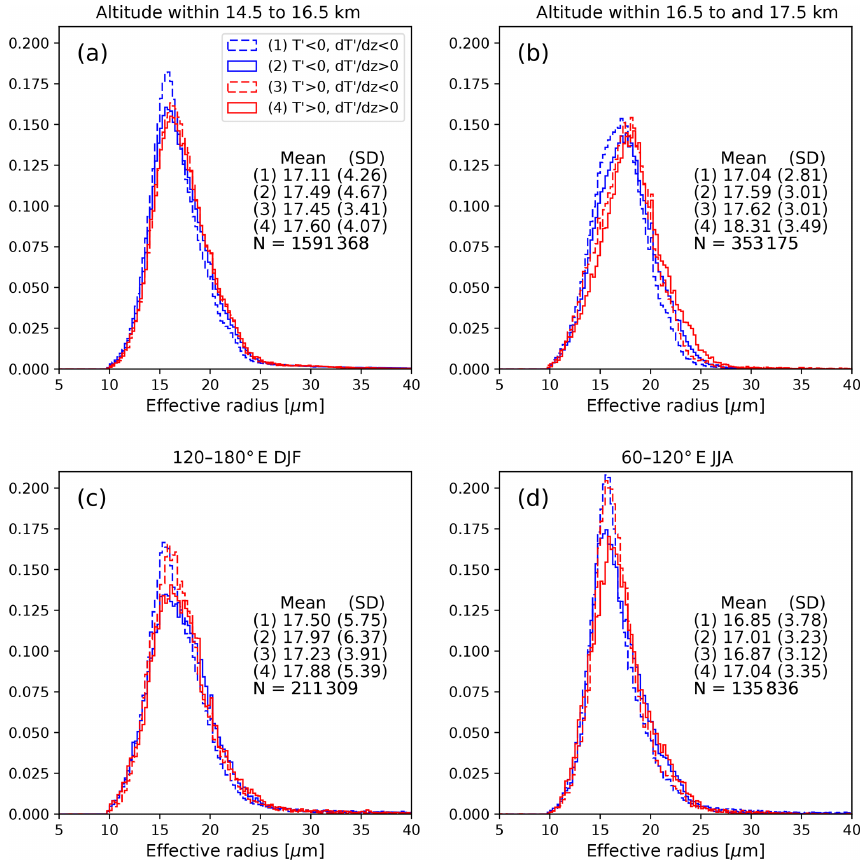
Figure 10. Normalized density function of r e in each gravity wave phase for clouds within (a) altitudes of 14.5 to 16.5km, (b) 16.5 to 17.5km, (c) 120–180 ◦ E in December–January–February, and (d) 60–120 ◦ E in June–July–August. The mean and standard deviation (SD) of r e in each phase and the total number of r e samples ( N ) are denoted in the